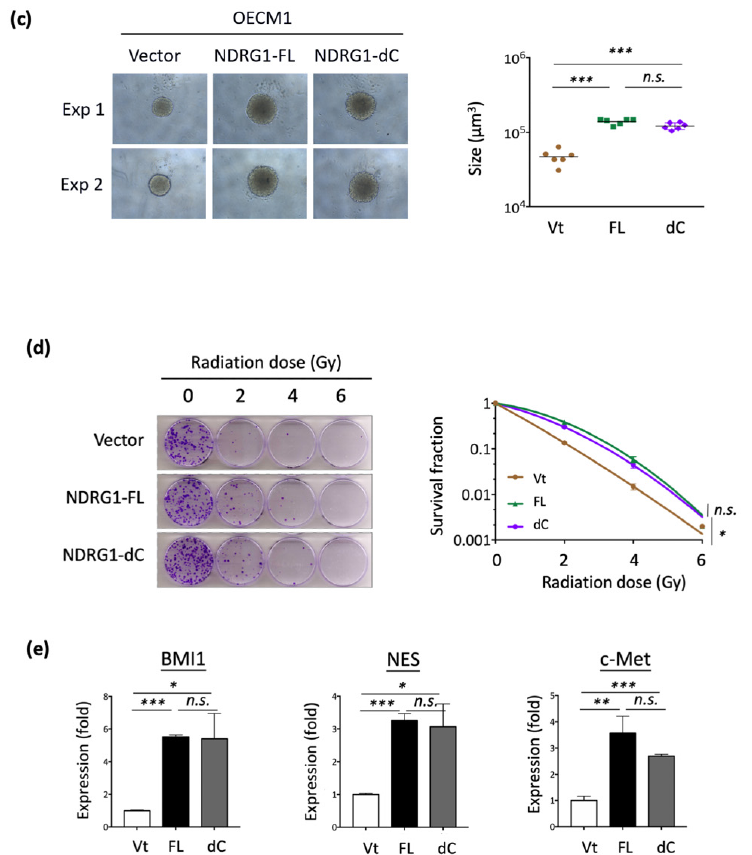
Figure 4. NDRG1-3R motif has minimal effect on cancer stemness. ( a ) Illustration of various NDRG1 truncated forms of EGFP tagged plasmid constructs (NDRG1-FL and NDRG1-dC). NDRG1-FL is composed of 394 amino acids; NDRG1-dC is composed of 337 amino acids, which lost the 3R motif. The mutations of GSK3b phosphorylation site of NDRG1 (NDRG1-3mt) are located at the 3R motif, which was made by triple serine-to-alanine substitutions (S342A, and S352A and S362A). ( b ) Confirmation of the various NDRG1 truncated forms’ expressions by Western blot analysis. After transfection of the NDRG1-FL, NDRG1-dC, or the vector plasmid into HNC cells, cellular proteins were extracted and subjected to Western blot analysis for NDRG1 expression. ( c ) Deletion of the C-terminal domain has no influence on NDRG1-induced cancer stemness. After transfection of the NDRG1-FL, NDRG1-dC, or the vector plasmid into HNC cells, the effect of NDRG1 on stem-like property was determined by spheroid cell formation. ( d ) Deletion of the C-terminal domain has no significant influence on NDRG1-induced radioresistance compared to NDRG1-FL, as determined by clonogenic survival assay in OECM1 cells. The error bars shown in the relevant figures indicate the standard deviation of the quantification results in the experiments. (* p < 0.05; n.s., no significance; ANOVA test). ( e ) After transfection of the NDRG1-FL, NDRG1-dC, or the vector plasmid into OECM1 cells, RNA was extracted and subjected to RT-qPCR analysis for cancer stemness markers. All the experiments were performed three times independently and typical results were shown. The error bars shown in the relevant figures indicate the standard deviation of the quantification results in all experiments. (* p < 0.05; ** p < 0.01; *** p < 0.001; n.s., no significance; t -test). The effects on cancer stemness are shown in Figure 4c. Spheroid cell formation was significantly increased in response to NDRG1-FL transfection. This ability was also ob- served in NDRG1-dC transfectants, suggesting that the 3R-motif of NDRG1 has a negligible effect on cancer stemness. Similar results were observed for NDRG1 in radioresistance. As shown in Figure 4d, transduction with NDRG1-FL promoted radioresistance in OECM1 cells. This effect existed even without the C-terminal domain, indicating a minimal effect of the 3R-motif on cancer